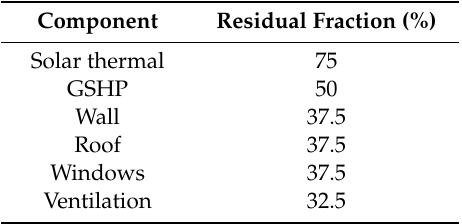
Table 9. Residual values of components at the end of the 25-year period as percentage of investment cost